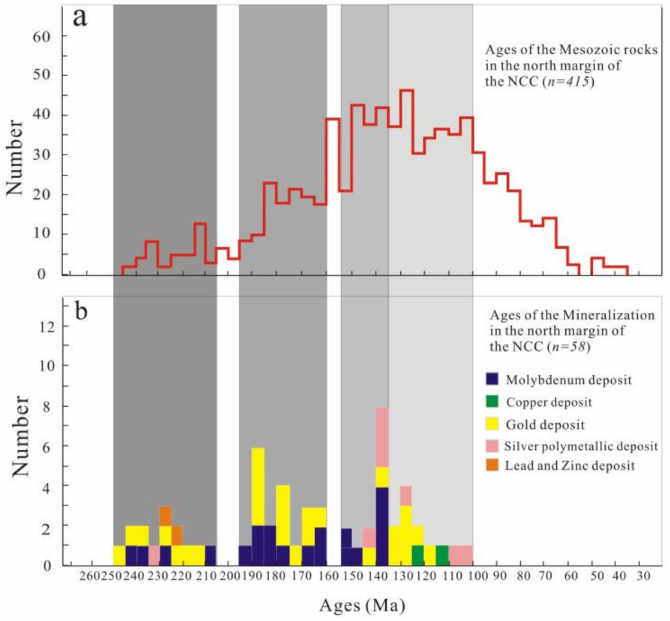
Figure 10. The ages of magmatic rocks ( a ) and mineralization ( b ) for the ore deposits on the northern flank of the North China Craton (NCC) (refer to Table 4 for data) formed during the Mesozoic.